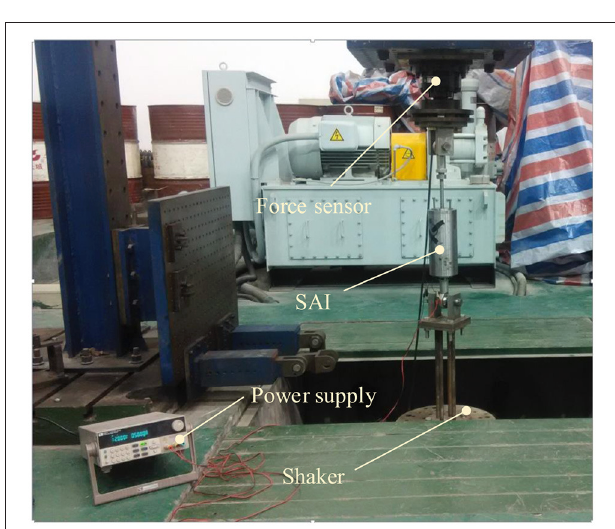
FIGURE 3 | Experimental setup for the SAI.